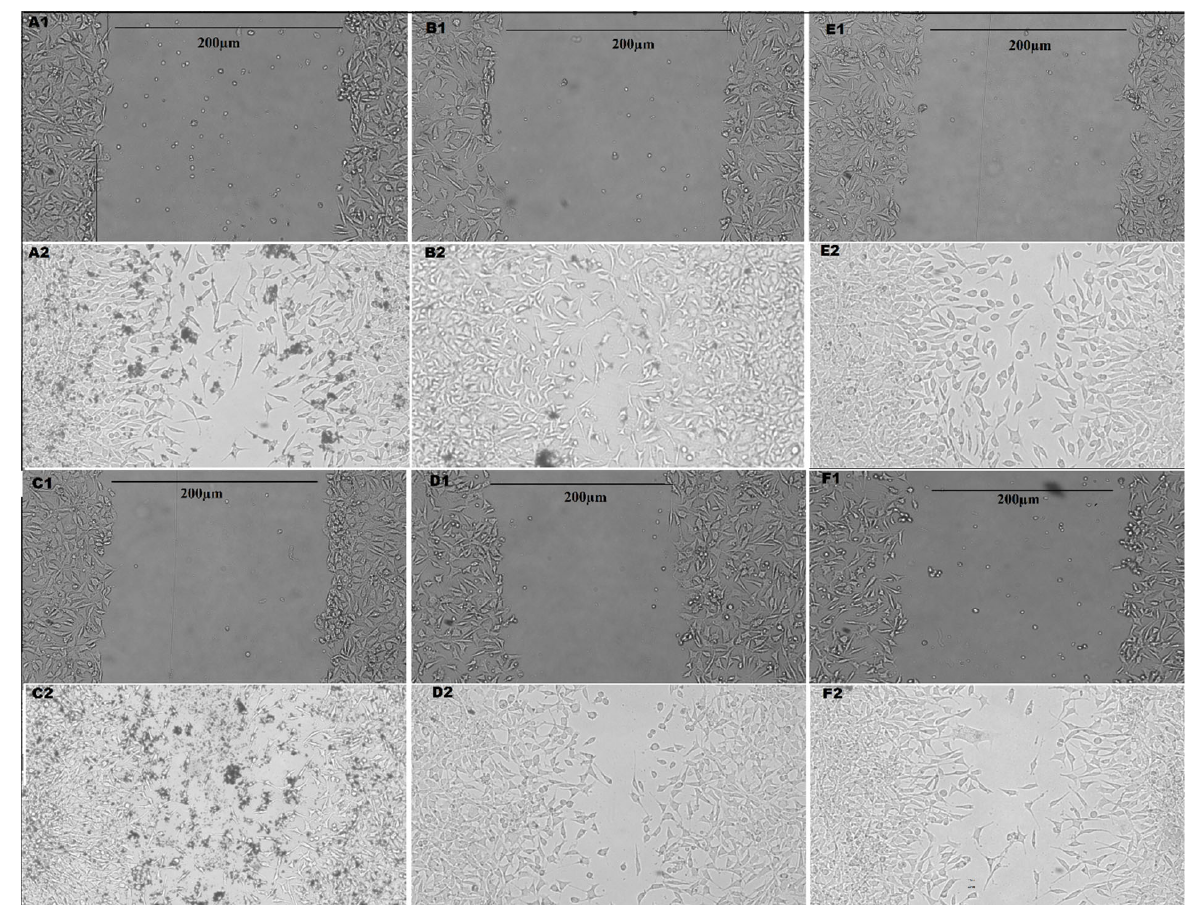
Figure 5. Effects of 50 ug/mL concentrations of hBN, hBN ‐ ALA, C 4 B, C4B ‐ ALA, and ALA on HDF cells culture monitored at 20× magnification under the invert microscope. ( A1 ) hBN at 0 h, ( A2 ) hBN at 24 h, ( B1 ) hBN ‐ ALA at 0 h, ( B2 ) hBN ‐ ALA at 24 h, ( C1 ) B 4 C at 0 h, ( C2 ) B 4 C at 24 h, ( D1 ) B 4 C ‐ ALA at 0 h, ( D2 ) B 4 C ‐ ALA at 24 h, ( E1 ) ALA at 0 h, ( E2 ) ALA at 24 h, ( F1 ) Control at 0 h, ( F2 ) Control at 24 h.